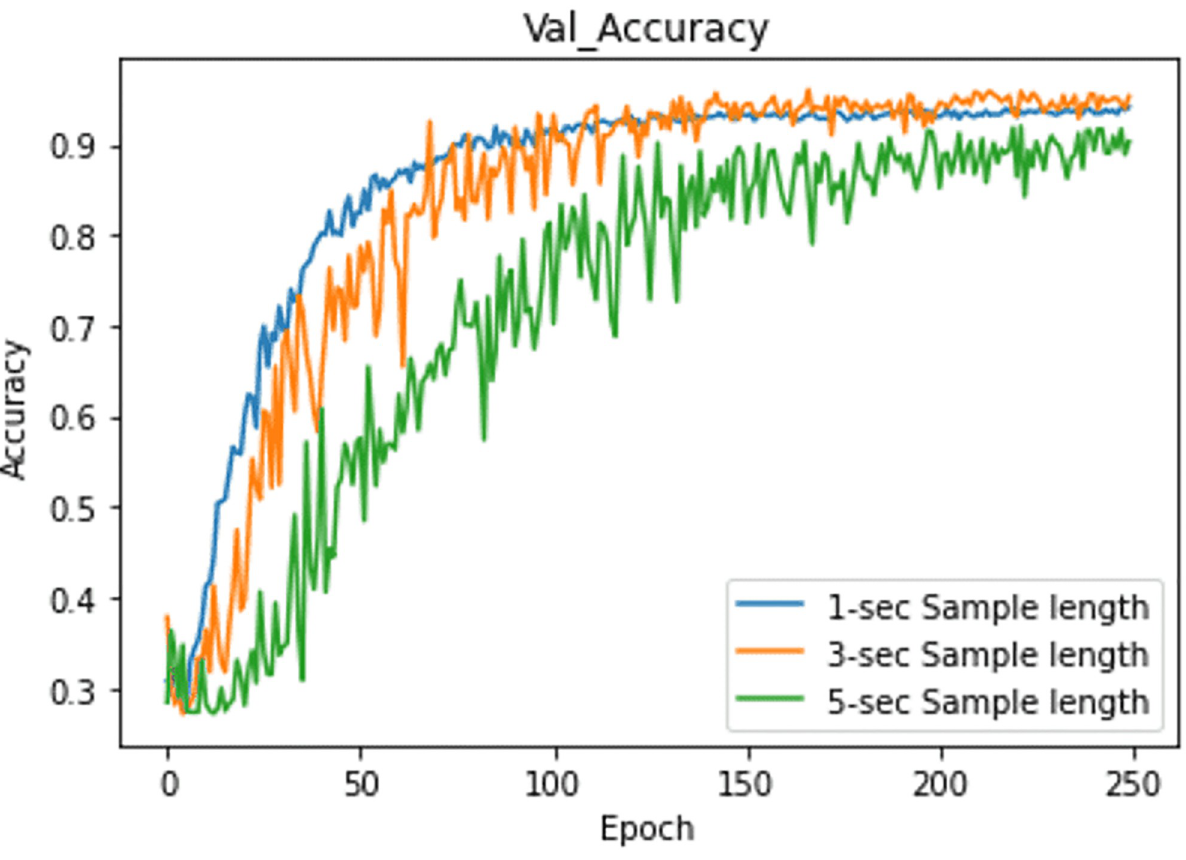
Fig 6. Experiment 2: Convergence curve in 250-epoch